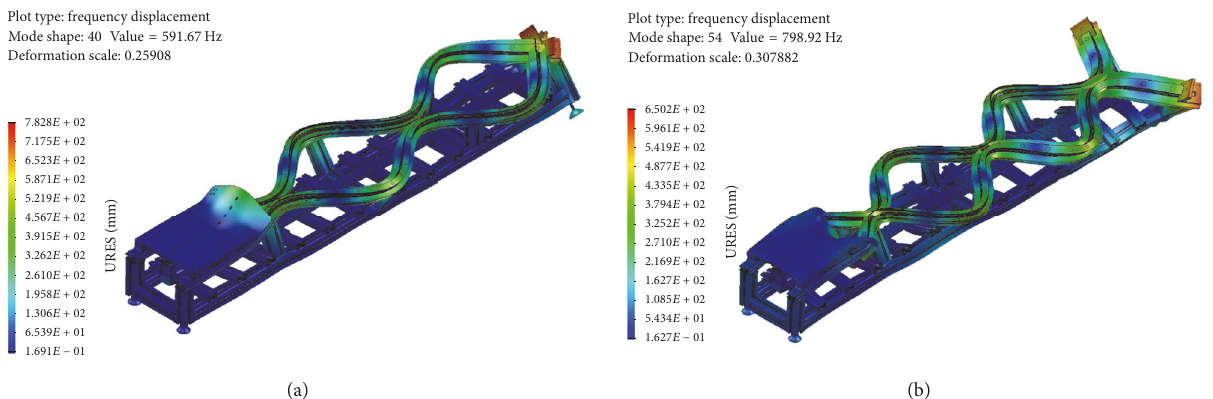
Figure 16: Deformation waves with transversal displacement at top lateral bars at position P5: (a) 5th-order mode (#40) ( 𝑓 ≈ 592 Hz, def. scale = 0.259); (b) 6th-order mode (#54) ( 𝑓 ≈ 799 Hz, def. scale ≈ 0.308).